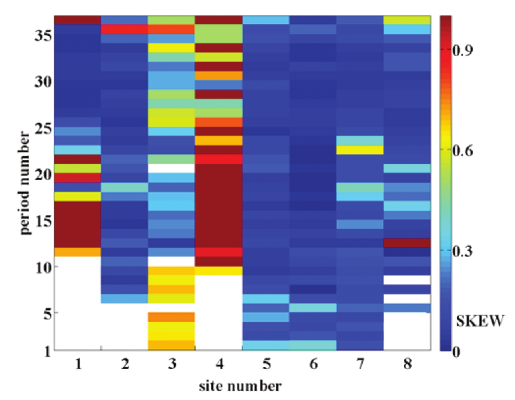
Fig. 4. Swift’s skew as a function of period and CSAMT site number. Skew values below 0.2 indi- cate a 1D/2D nature of the dataset.